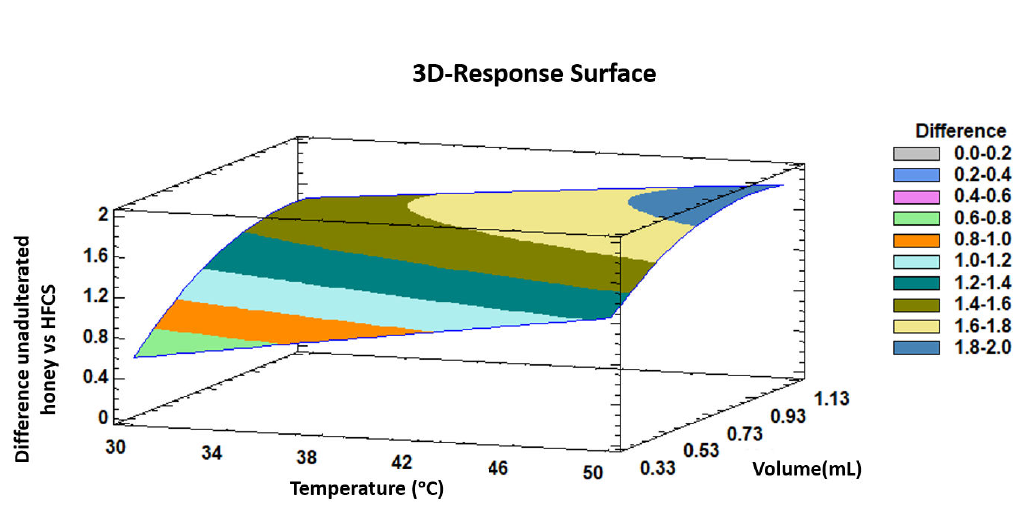
Figure 3. 3D surface plot of the Box–Behnken design that represents graphically, according to the polygonal equation, the influence of temperature and injection volume on the intensity differences between unadulterated honey samples and HFCS